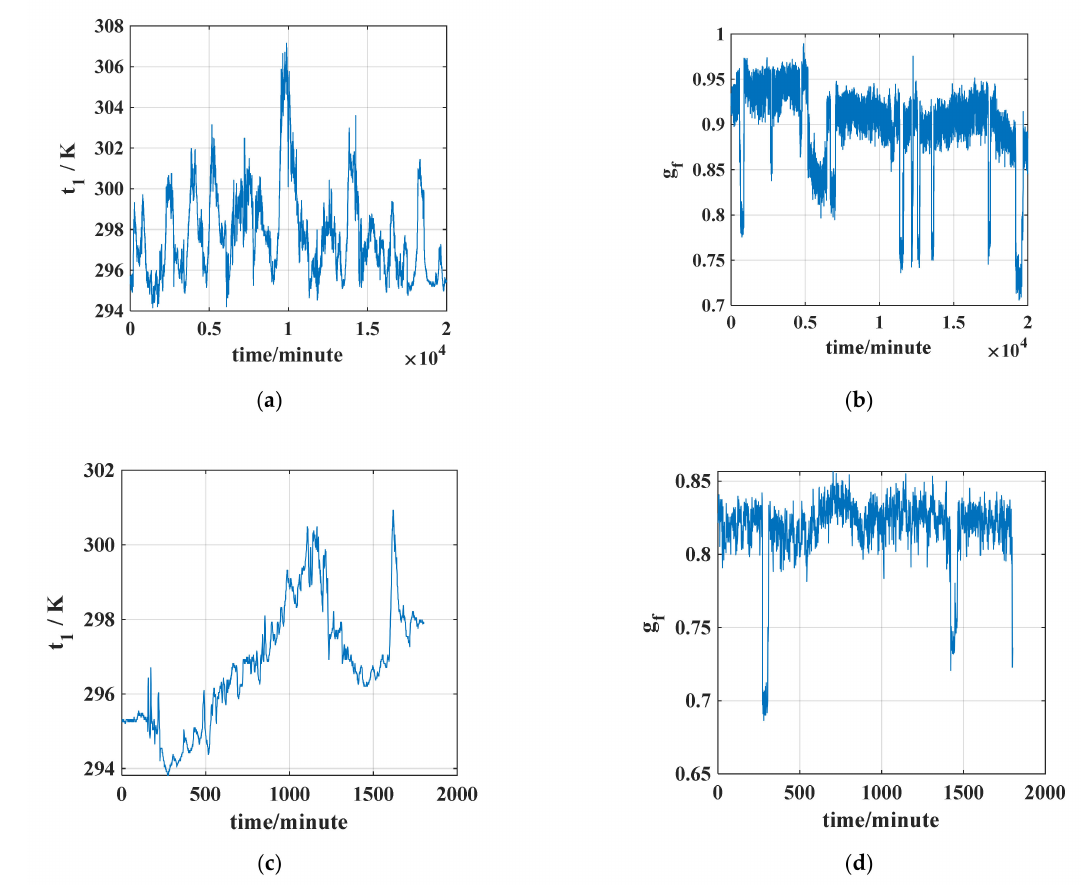
Figure 7. Input parameters of normal data and fault data: ( a ) Ambient temperature of normal data; ( b ) Fuel flow rate of normal data; ( c ) Ambient temperature of fault data; ( d ) Fuel flow rate of fault data.